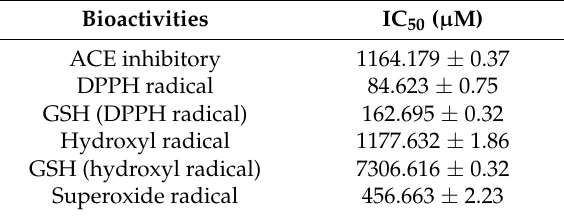
Table 4. IC 50 values of the Ser-Tyr.